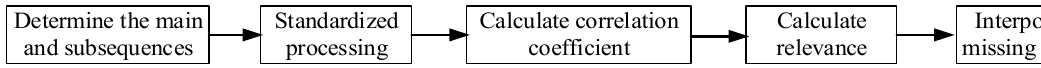
Figure 4. The data interpolation process based on method of grey correlation.